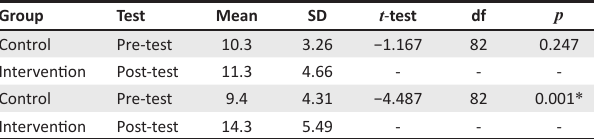
TABLE 2: Independent samples t -test (pre- and post-test of both schools) for Chitonga.